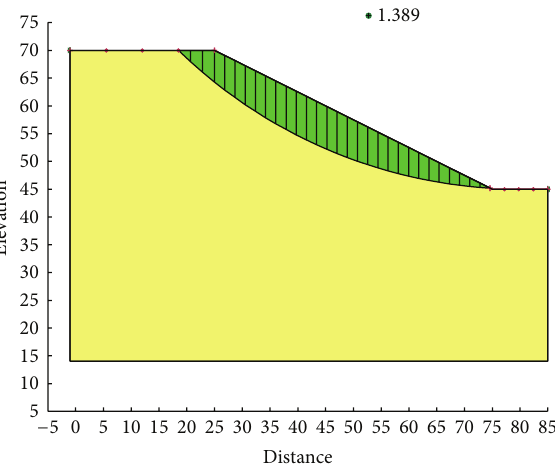
Figure 9: Critical failure surface with the Janbu method.